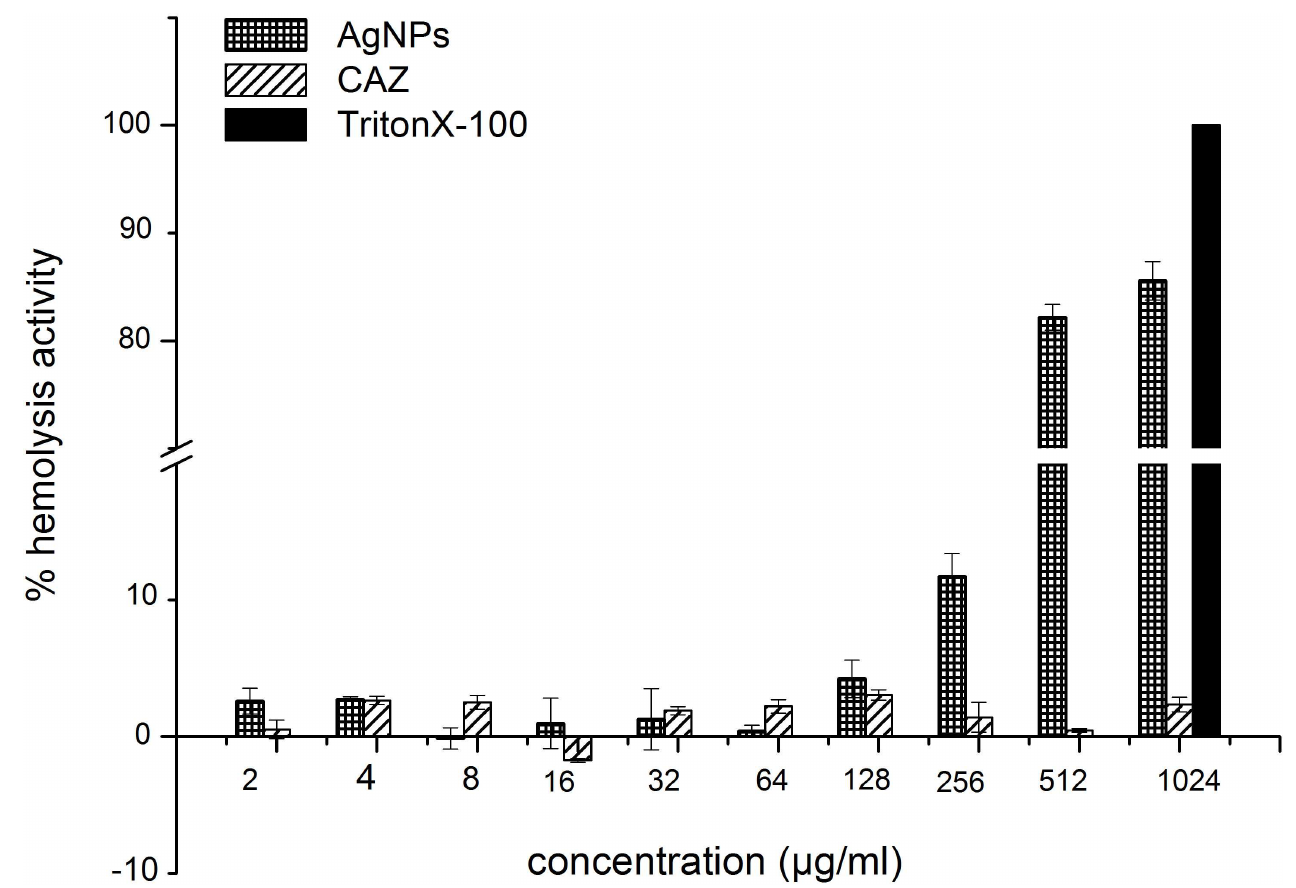
Fig 3. Hemolytic activity of AgNPs. Human erythrocytes were incubatedin PBS with variousconcentrations of AgNPs for 1 hr at 37˚C. The hemoglobin release was monitoredusing a microplatereader at the absorbance at 405 nm. Data representthe means ± standarderrors of the means for triplicate samples. Results shown are representative of two